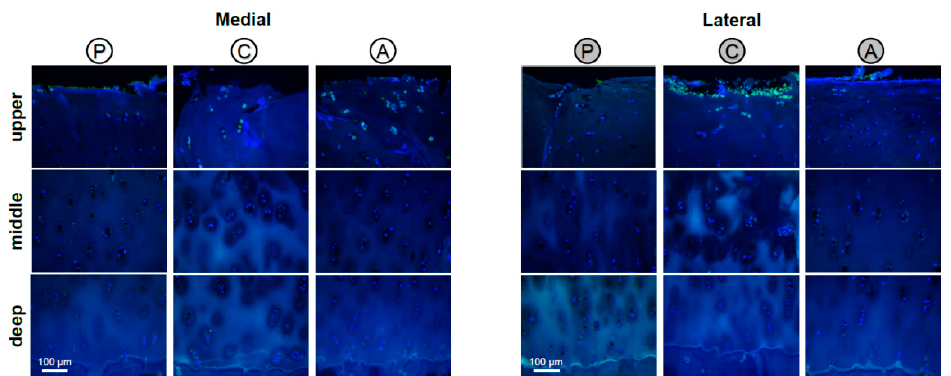
Figure A1. Immunofluorescence staining of PLS3 in chondrocytes on articular cartilage sections. PLS3 could be detected in chondrocytes of the upper, middle and deep cartilage zones from the different cartilage subregions (A: anterior, C: central, P: posterior) of the medial and lateral tibial compartments. The strongest staining was found in chondrocytes of the upper zone. Representative PLS3-stained sections of the different subregions from one patient are